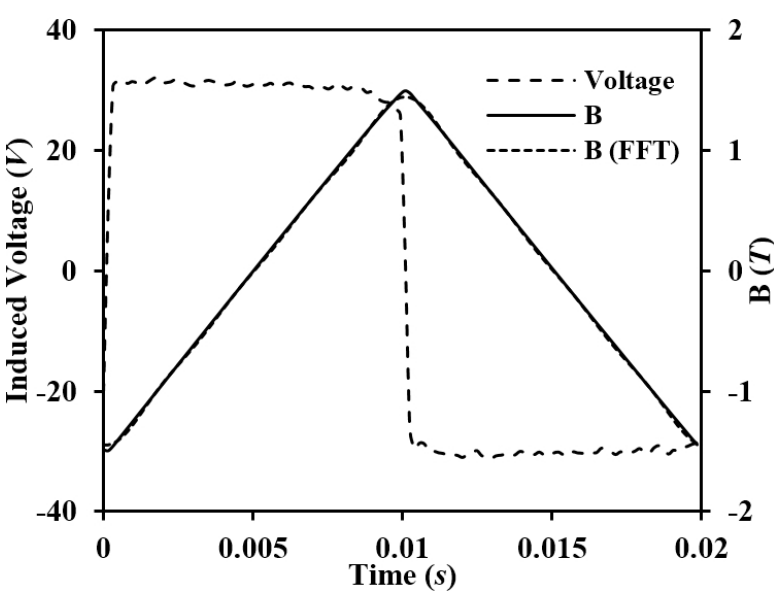
Figure 9. Waveforms of the induced voltage, flux density and its fast Fourier transform (FFT) results under the square excitation ( B peak = 1.5 T, f = 50 Hz).